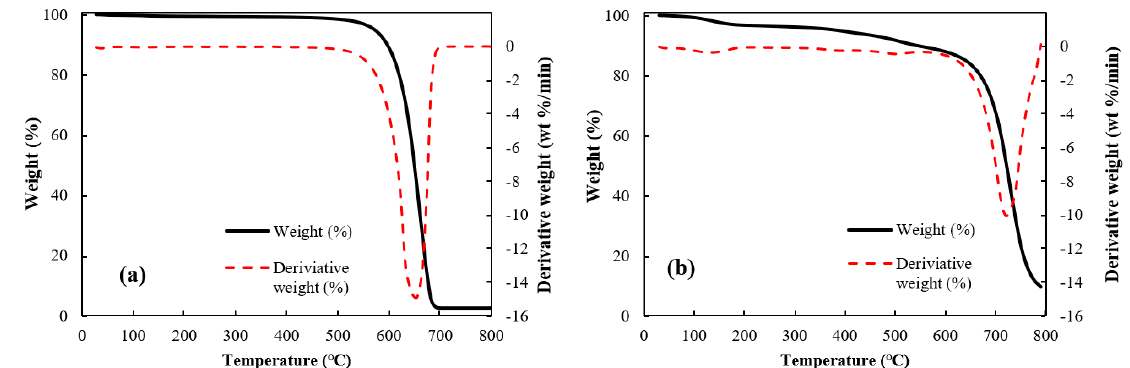
Figure 4. Thermal gravimetric analyses of CNTs: ( a ) raw MWCNT and ( b ) CNT microbead (case II).